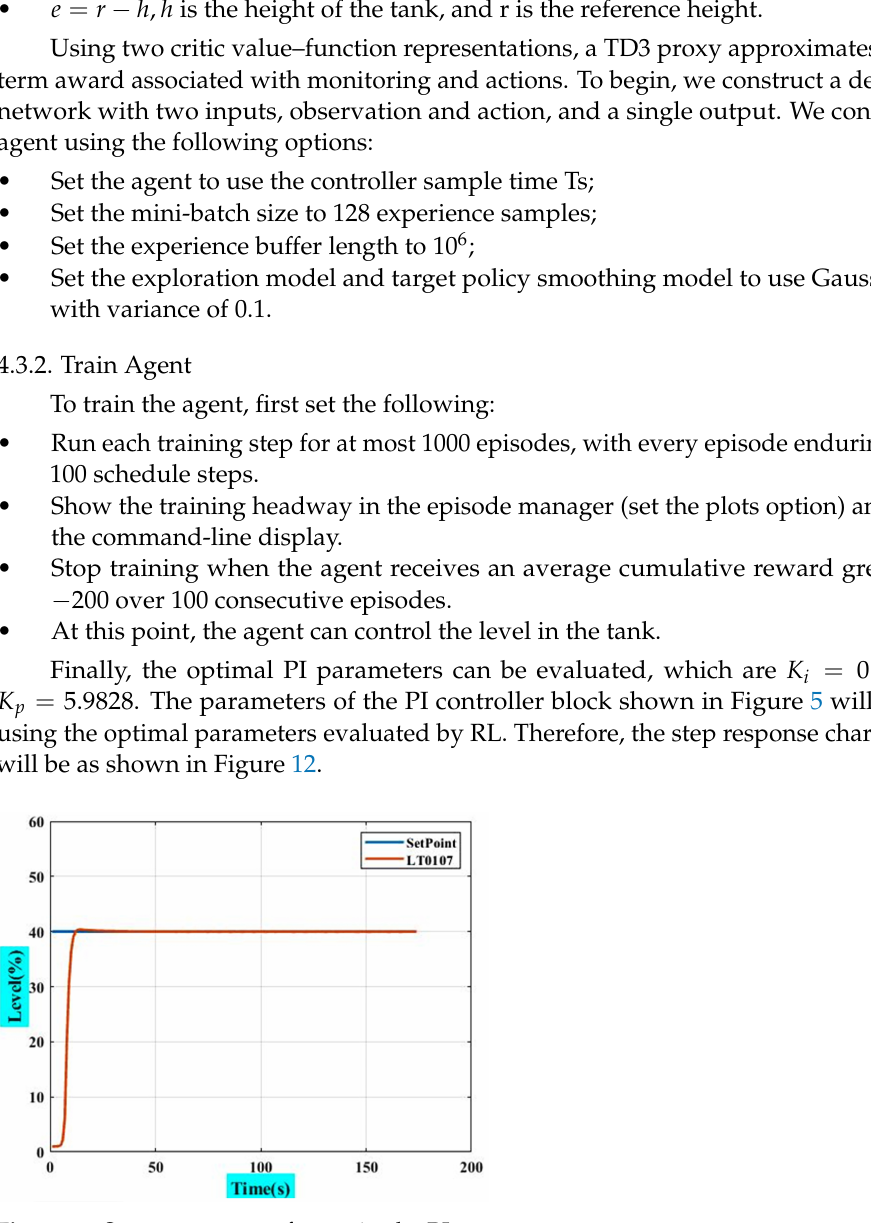
Figure 12. System response after tuning by